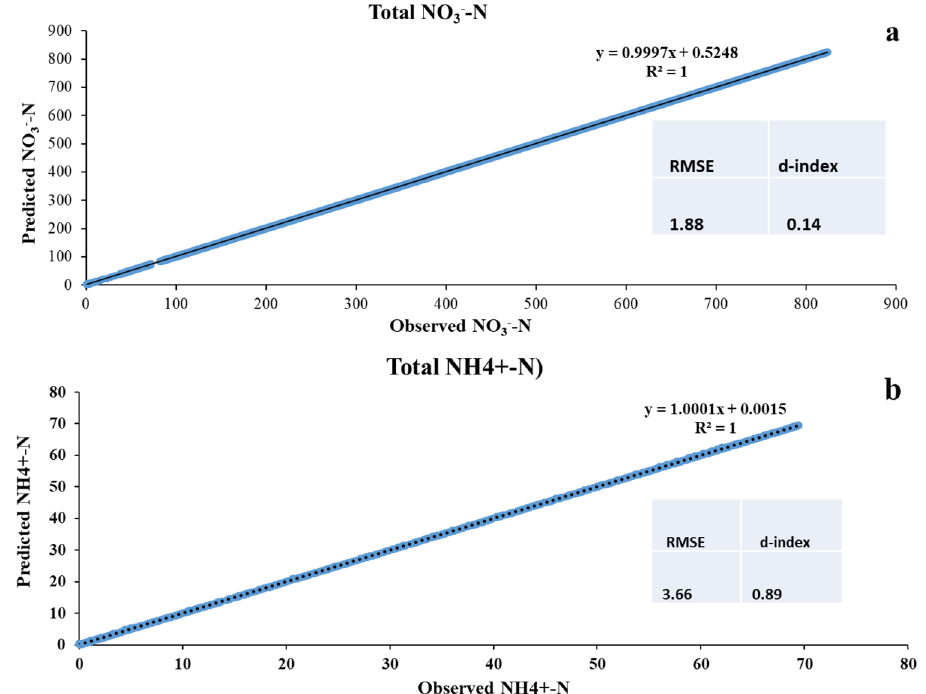
Figure 3. ( a ) APSIM total NO 3 − –N observed and simulated with R 2 value and RMSE. where R 2 represents the coefficient of determination and RMSE (root mean square error). ( b ) APSIM observed and simulated total NH 4 + –N with two different scenarios under the same weather condition and fertilizer inputs. The observed and simulated changes over 20 years of fertilization observed and predicted total NH 4 + –N calibration with R 2 and RMSE (root mean square